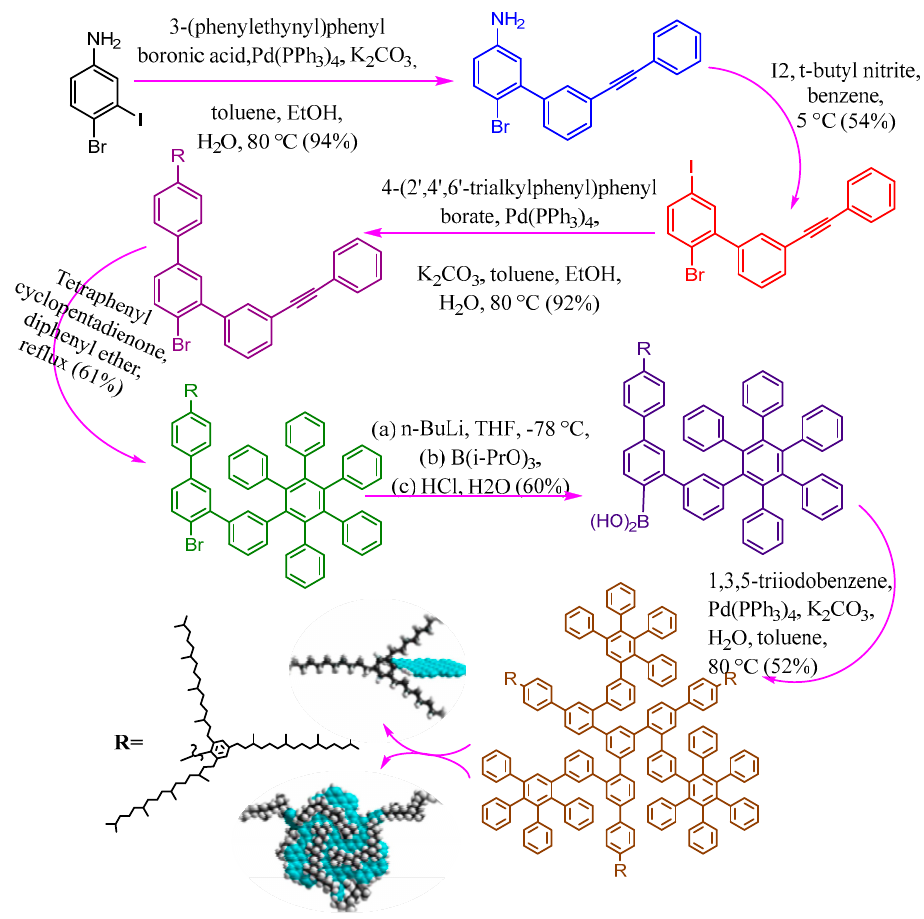
Figure 3. The synthetic procedures of colloidal GQDs with well-defined structures. Green chemistry is one of the fundamental branches of chemistry that provide golden solves for most problems with significant properties. Green chemistry has several ad- vantages including, safe, environmentally friendly, no need for hazardous materials, and can occur under normal conditions [60]. Green chemical procedures have been engaged in the formation of carbon dots from several natural sources counting chicken eggs, ani- mals [61], different plant species including fruits and vegetables [62], and waste materials like waste paper and frying oil [63]. There is an exponential increase in the number of research articles with both carbon quantum dots and green synthesis content. The fabri- cation processes can be achieved by different types of methods including hydrother- mal/solvothermal, microwave-assisted polymerization, pyrolysis, and carbonization [64]. These approaches are widely used in the synthesis of carbon dots and having several ad- vantages as displayed in Figure 4. In Table 1, conventional CQDs production methods, Figure 4. Advantages of different current routes used for the preparation of carbon dots. Table 1. Recent green quantum dots produced by the bottom-up approach (Hydrothermal, microwave-assisted, and py- rolysis) and their applications.